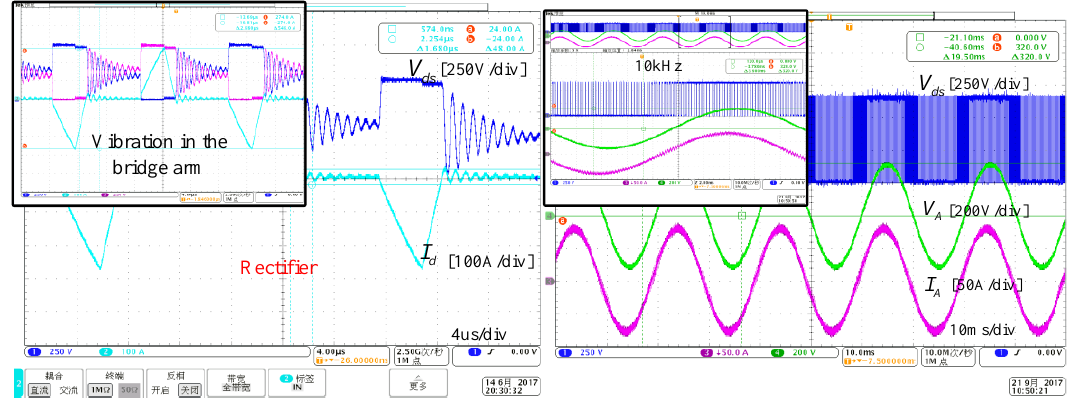
Figure 17. The rectifier waveform and three-phase inverter waveform.